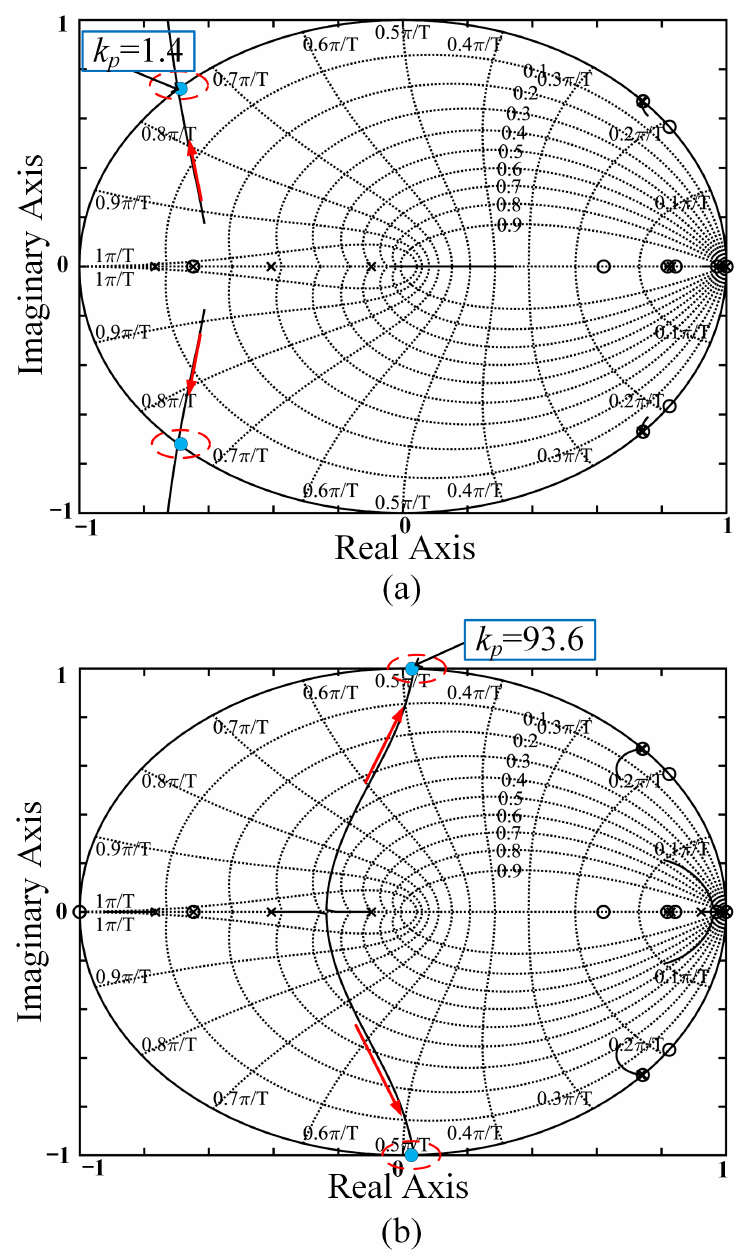
Figure 10. Distribution of closed-loop poles of the system: ( a ) without the low-pass filter. ( b ) with the low-pass